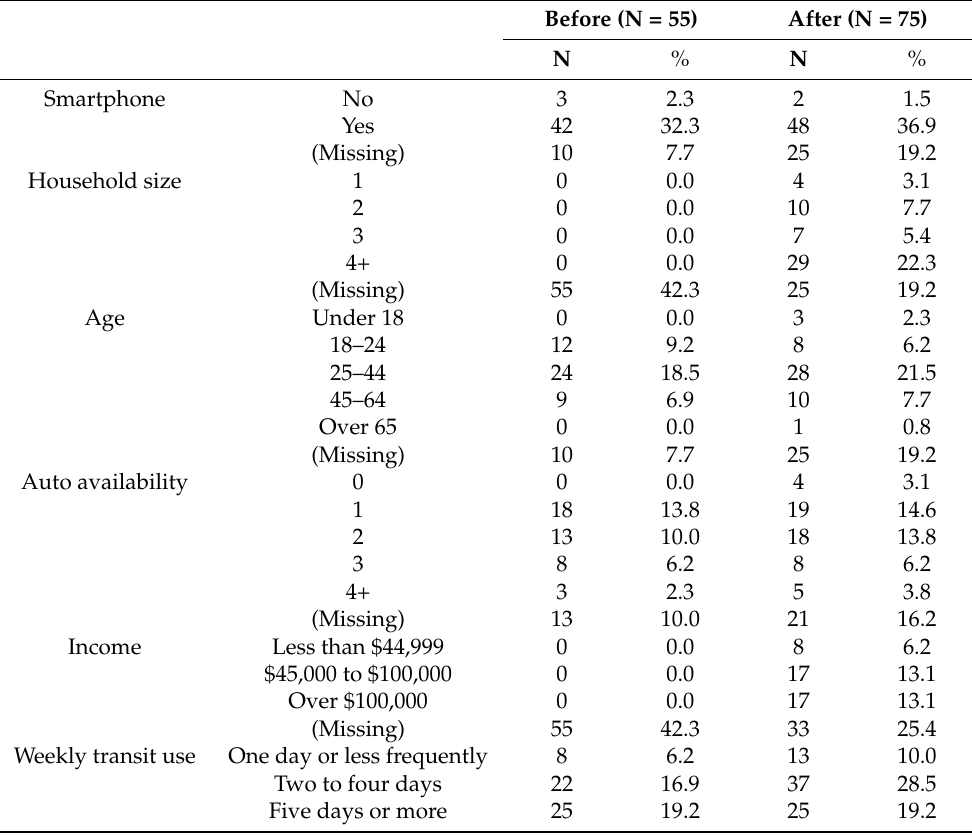
Table 2. Demographic Characteristics of Survey